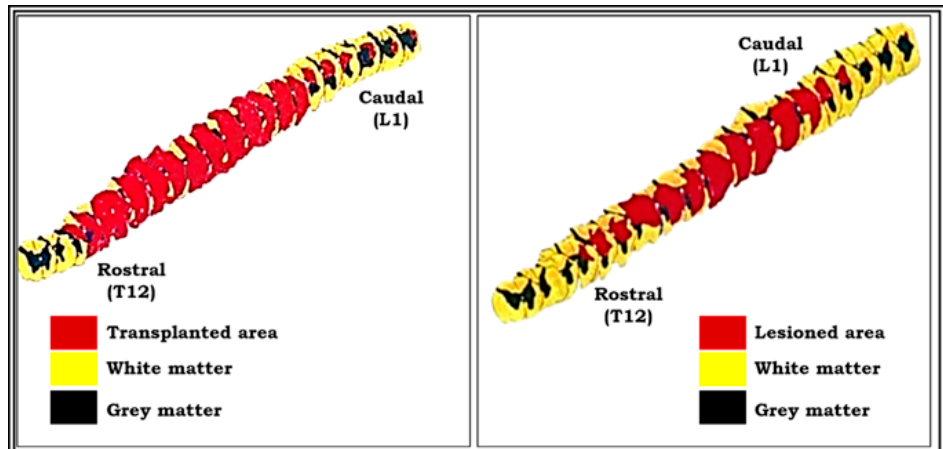
Figure 10. Pictures showing three-dimensional graphic representation of the unilateral hemisected segment of spinal cord (pop 360 days) and transplanted segment of spinal cord (pop 360 days). Reconstruction was done on a centimeter graph paper using Nikon draw tube fitted to a Nikon labophot binocular light microscope with a magnification of 20 × . This was kept constant throughout for all the serials. Red-colored part shows the lesioned area, and yellow-colored part shows the intact area of spinal cord segment (see the procedure details for three-dimensional graphic reconstruction in materials and methods).